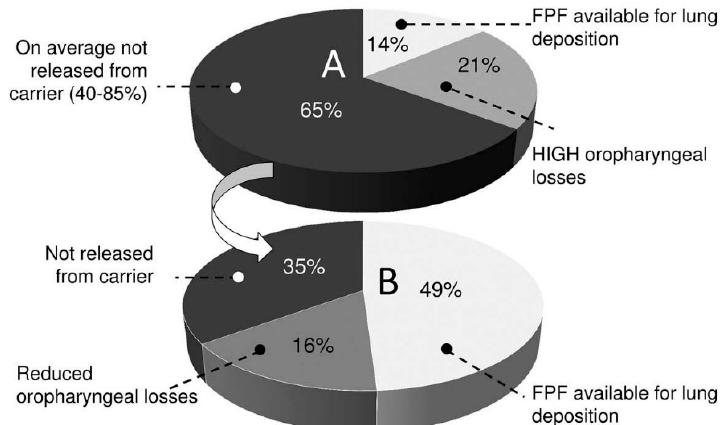
Figure 1. Fine particle fraction (FPF) of the dose delivered from dry powder inhaler (DPI) containing adhesive mixtures (carrier–drug formulations). ( A ) Representation of the actual situation with an FPF available for lung deposition of 14%, high oropharyngeal losses (21%) and about 65% of the drug not released from the carrier. ( B ) Representation of the ideal situation that would be 49% of FPF, lower oropharyngeal drug losses (16%) and lower drug rates (35%) that are not released from the carrier. Reproduced from [5], which is licensed under the terms of the Creative Commons Attribution- NonCommercial-NoDerivatives License (http://creativecommons.org/licenses/by-nc-nd/4.0/).